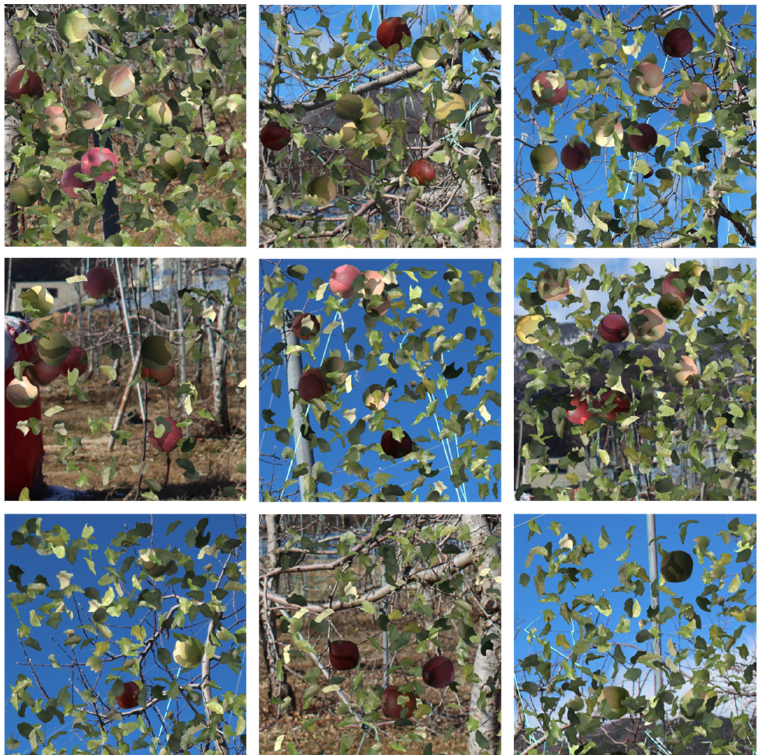
Figure 3. Examples of the generated training data. Red and green apples were randomly selected. Low luminance images were composited over the fruit image as a shadow of the leaf. For the shadow images, the aspect ratio, magnification, and angle were also varied to represent shadows of various shapes.